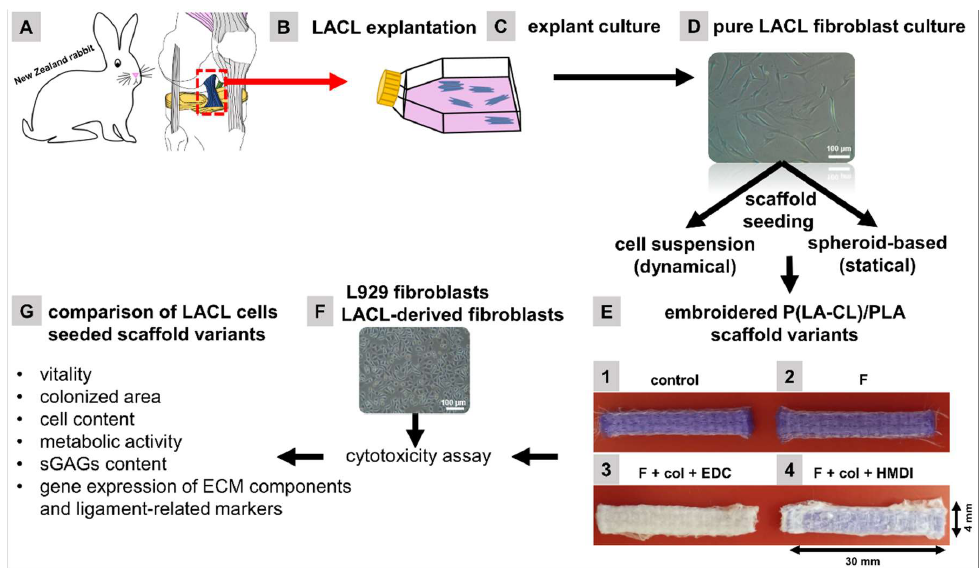
Figure 1. Dissection of the lapine (L) anterior cruciate ligament (ACL) of New Zealand rabbit ( A ). Cultivation of LACL fragments in T25 flasks as an explant culture for cell isolation ( B , C ). Expansion of LACL-derived fibroblasts ( D ). Embroidered P(LA-CL)/PLA scaffolds were treated with different functionalization methods (none [ E1 ], with 10% fluorine in the gas-phase of the fluorination batch reactor [ E2 ], with fluorine + collagen foam + ethylcarbodiimide [EDC] [ E3 ] and with fluorine + collagen foam + hexamethylene diisocyanate [HMDI] [ E4 ]), tested for cytotoxicity with L929 and LACL-derived fibroblasts ( F ) and then seeded either with a LACL-derived fibroblast suspension in a dynamical or with spheroids in a statiical approach. Downstream analysis ( G ) comprised determination of cell vitality, areas colonized by cells, cell number, metabolic activity, sulfated glycosaminoglycan (sGAG) contents and expression analysis for ligament main ECM and marker genes. E3 : The EDC treatment evoked a loss of the blue color of the scaffolds. Col, collagen foam; F, fluorinated; EDC, ethylcarbodiimide cross-linked; HMDI, hexamethylene diisocyanate cross-linked.